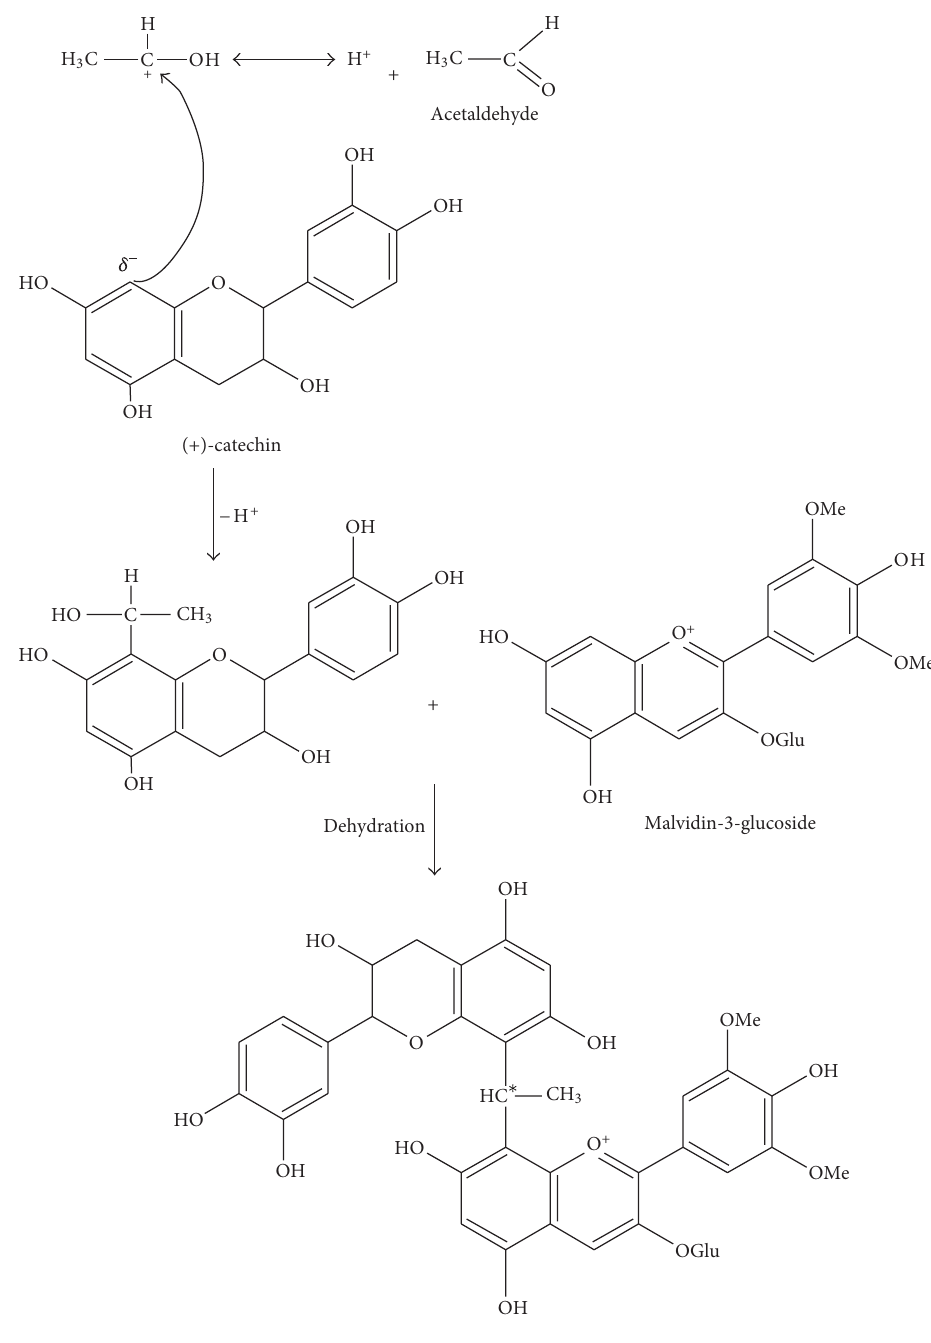
F 6: Formation of anthocyanin-methylmethine-�avanol compounds by reaction between (�)-catechin and